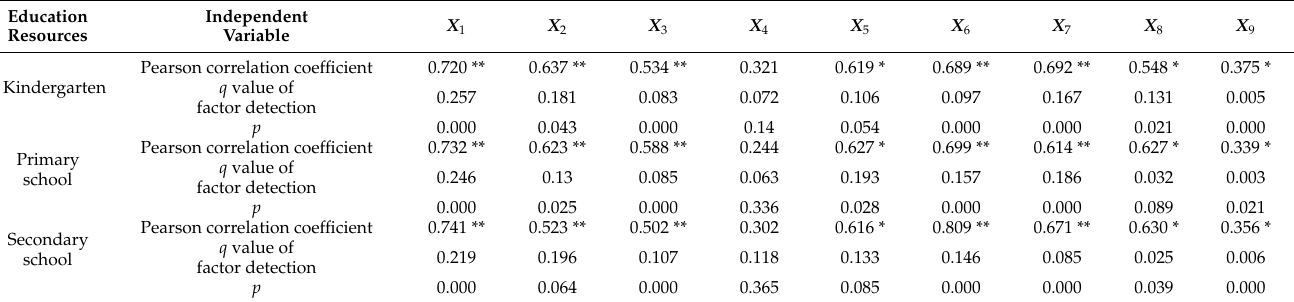
Table 5. Results of Pearson correlation coefficients and factor